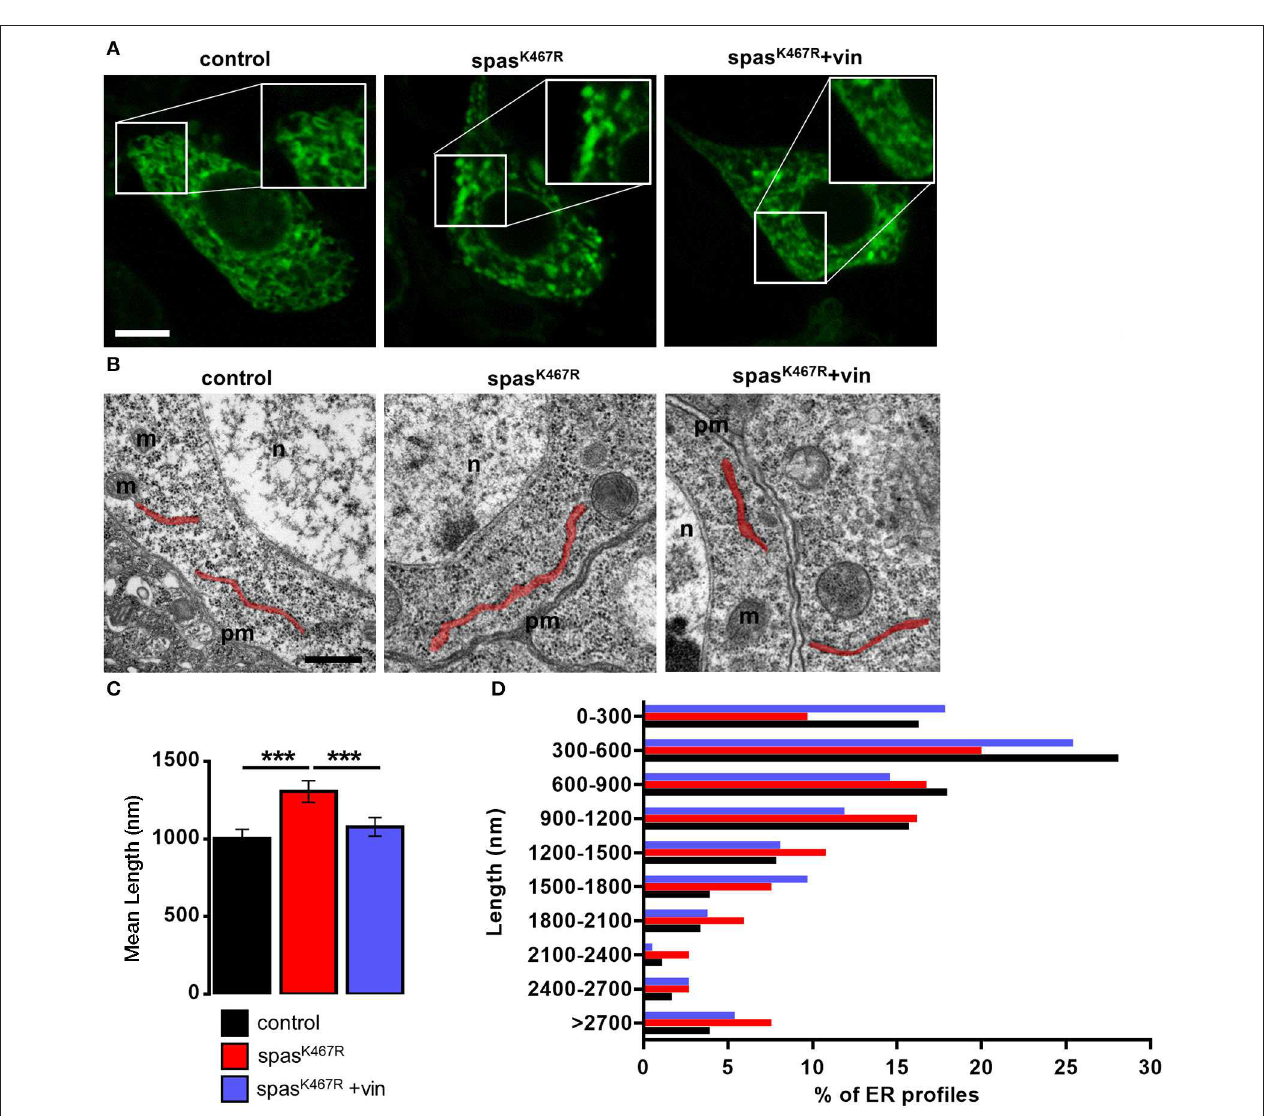
FIGURE 1 | (A) Ventral ganglion motor neurons cell bodies of larvae of the indicated genotypes co-expressing BiP-sf-GFP-ER were imaged at the confocal microscope. Where indicated, spastin K467R flies were raised in vinblastine-containing food (50nM). Scale bar, 5 µ m. (B) TEM images of ventral ganglion neuronal cell bodies of larvae expressing spastin K467R and relative control; ER profiles are highlighted in red. pm, plasma membrane; n, nucleus; m, mitochondria. Scale bar, 500nm. (C) Quantification of the mean length of ER profiles in TEM images for the indicated genotypes. Mean ± SEM, n ≥ 50 profiles. *** p < 0.001. (D) Distribution of ER profile length in TEM images. The percentage of measured profiles for each 300 nm-class is reported for the indicated genotypes.